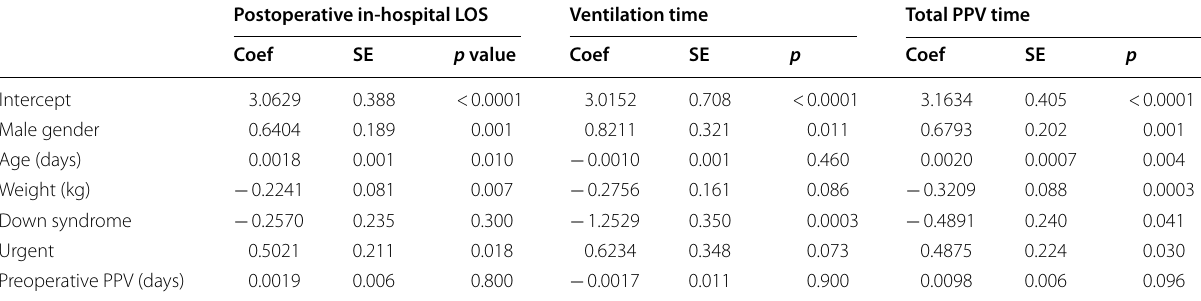
Coef, coefficient; LOS, length of stay; PPV, positive pressure ventilation; SE, standard